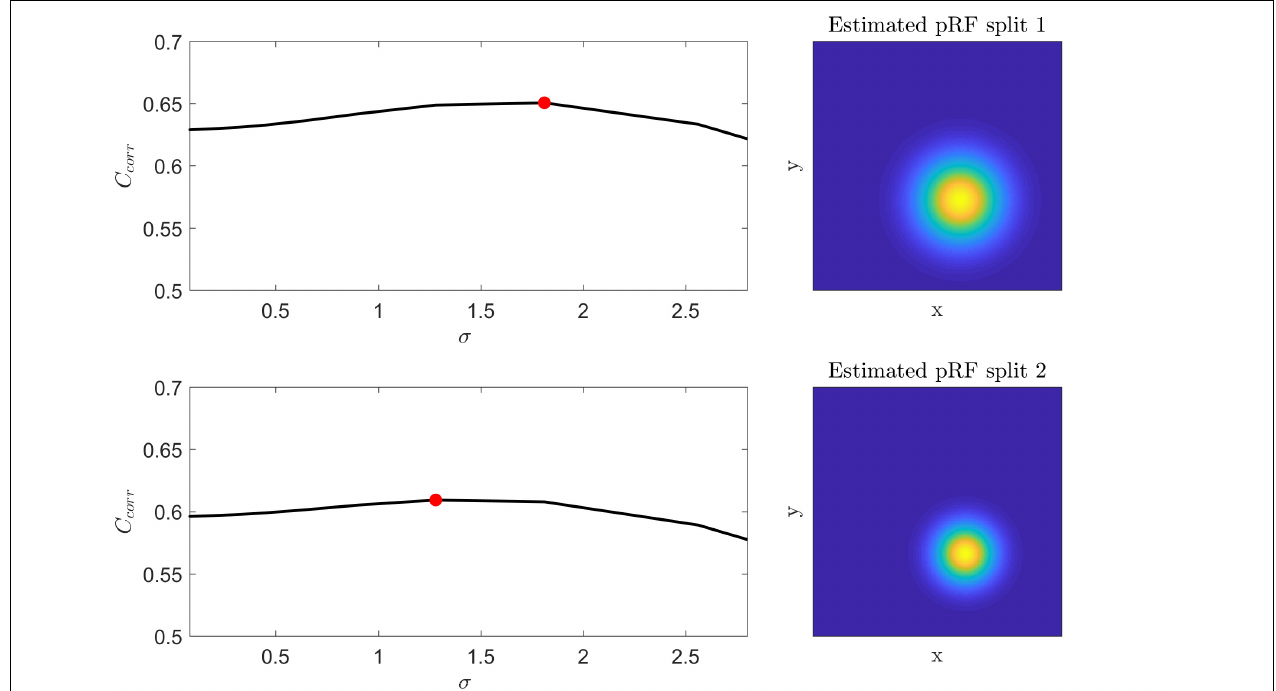
FIGURE 5 | Left: Cost function (correlation coefficient) as a function of the pRF size ( σ ) for the two splits of a voxel in the HCP dataset. The cost function was computed by fixing the voxel’s pRF mean ( x , y ) to the value of the best fit model that corresponds to the global maximum (red dot in the figure). Right: The corresponding estimated pRFs for each